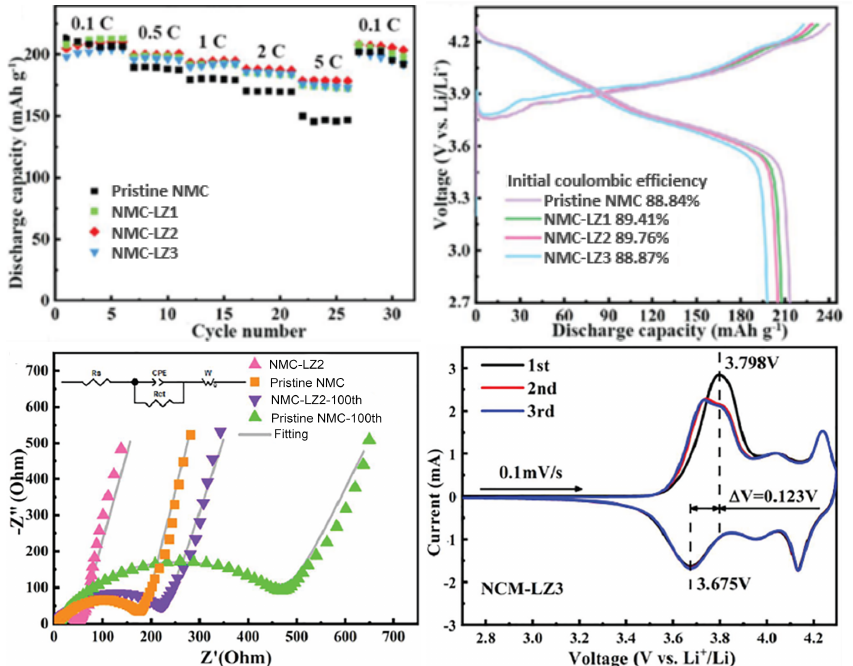
Figure 15. La 2 Zr 2 O 7 coated and Zr doped NMC cathode: ( Top left ) rate capacity and ( Top right ) charge/discharge curves, ( Bottom left ) Nyquist plots and ( Bottom right ) cyclic voltammetry curves. Graphs for pristine and different coating/doping wt% samples (LZ x , x in wt%). Reproduced with permission